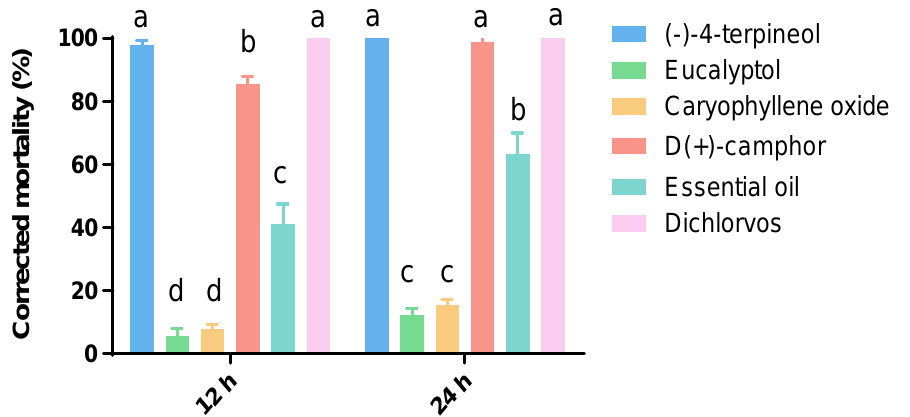
Figure 3. Toxicity of major compounds of A. lavandulaefolia essential oil against P. xylostella larvae in comparison to the essential oil and the positive control, 12 h and 24 h after fumigation. The values are expressed as the means + standard error of each experiment. Bars followed by the same letter in each time interval are not significantly different using Tukey’s HSD test at p < 0.05.